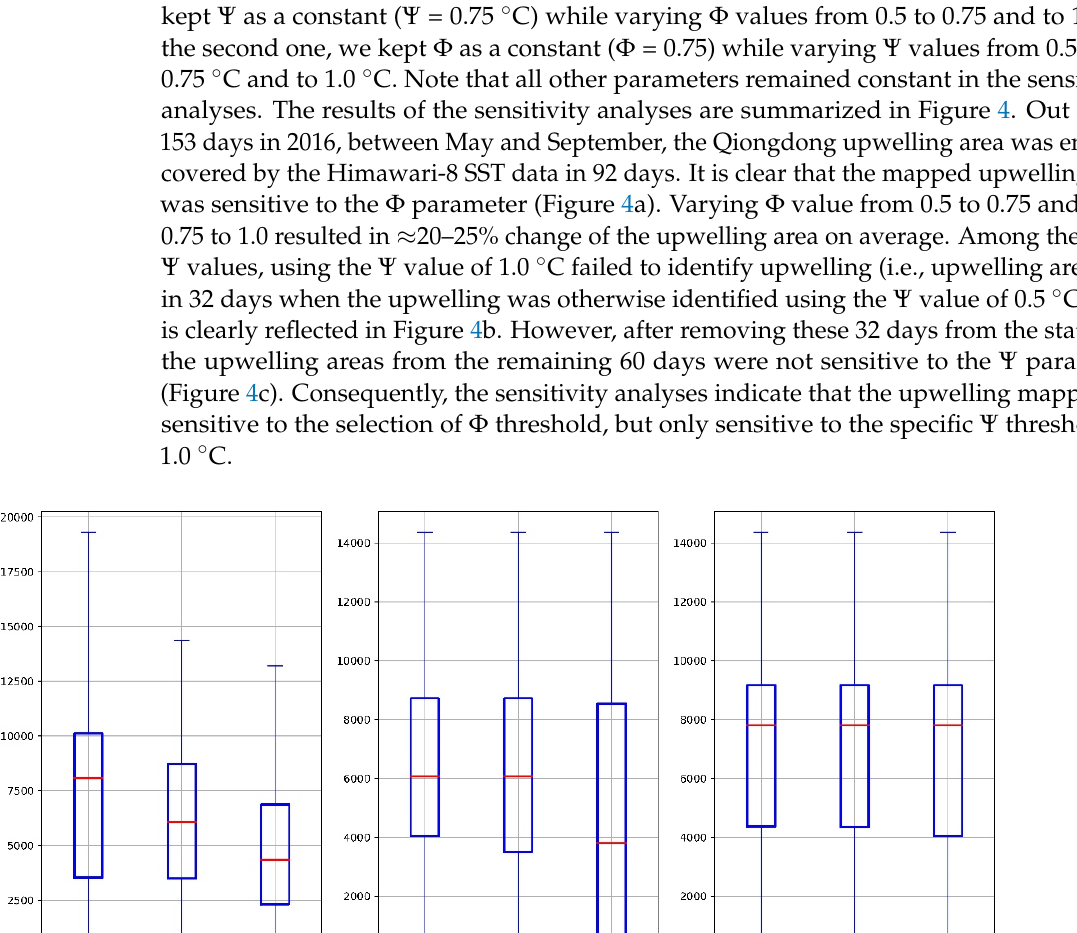
Figure 3. Upwelling region calculation process. ( a ) The Himawari-8 Sea Surface Temperature (SST) image on 17 July 2016; ( b ) Topographic Position Index (TPI) calculated from SST image; ( c ) upwelling region calculated by TPI (the region within black solid line).